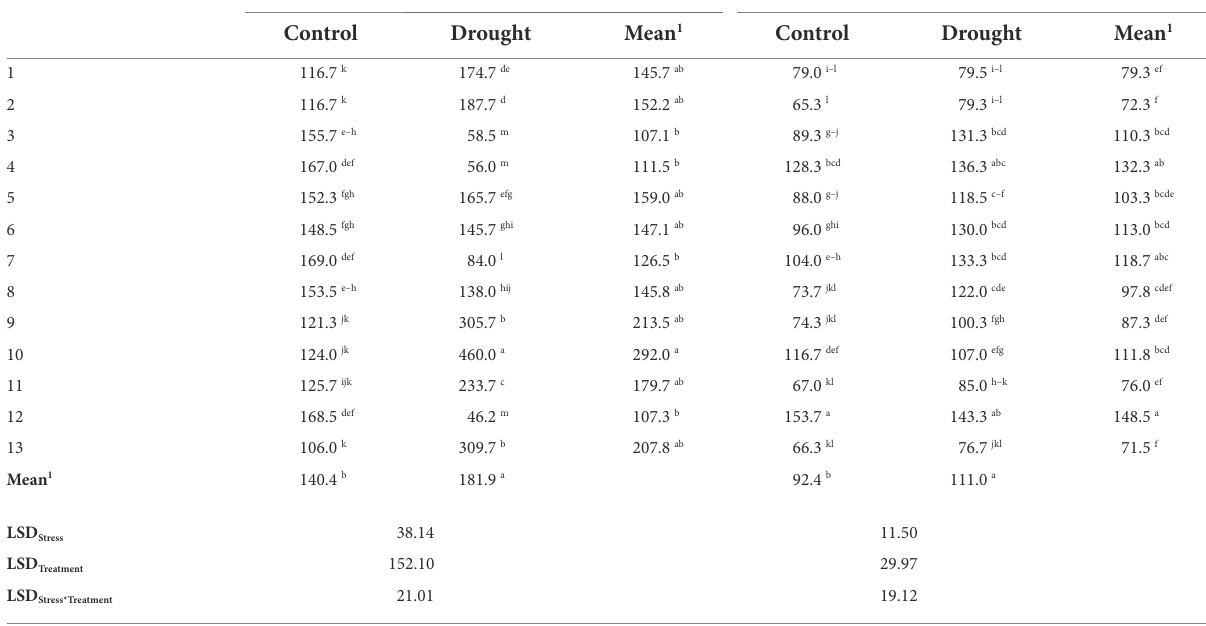
Treatment * During drought stress 2 After regeneration